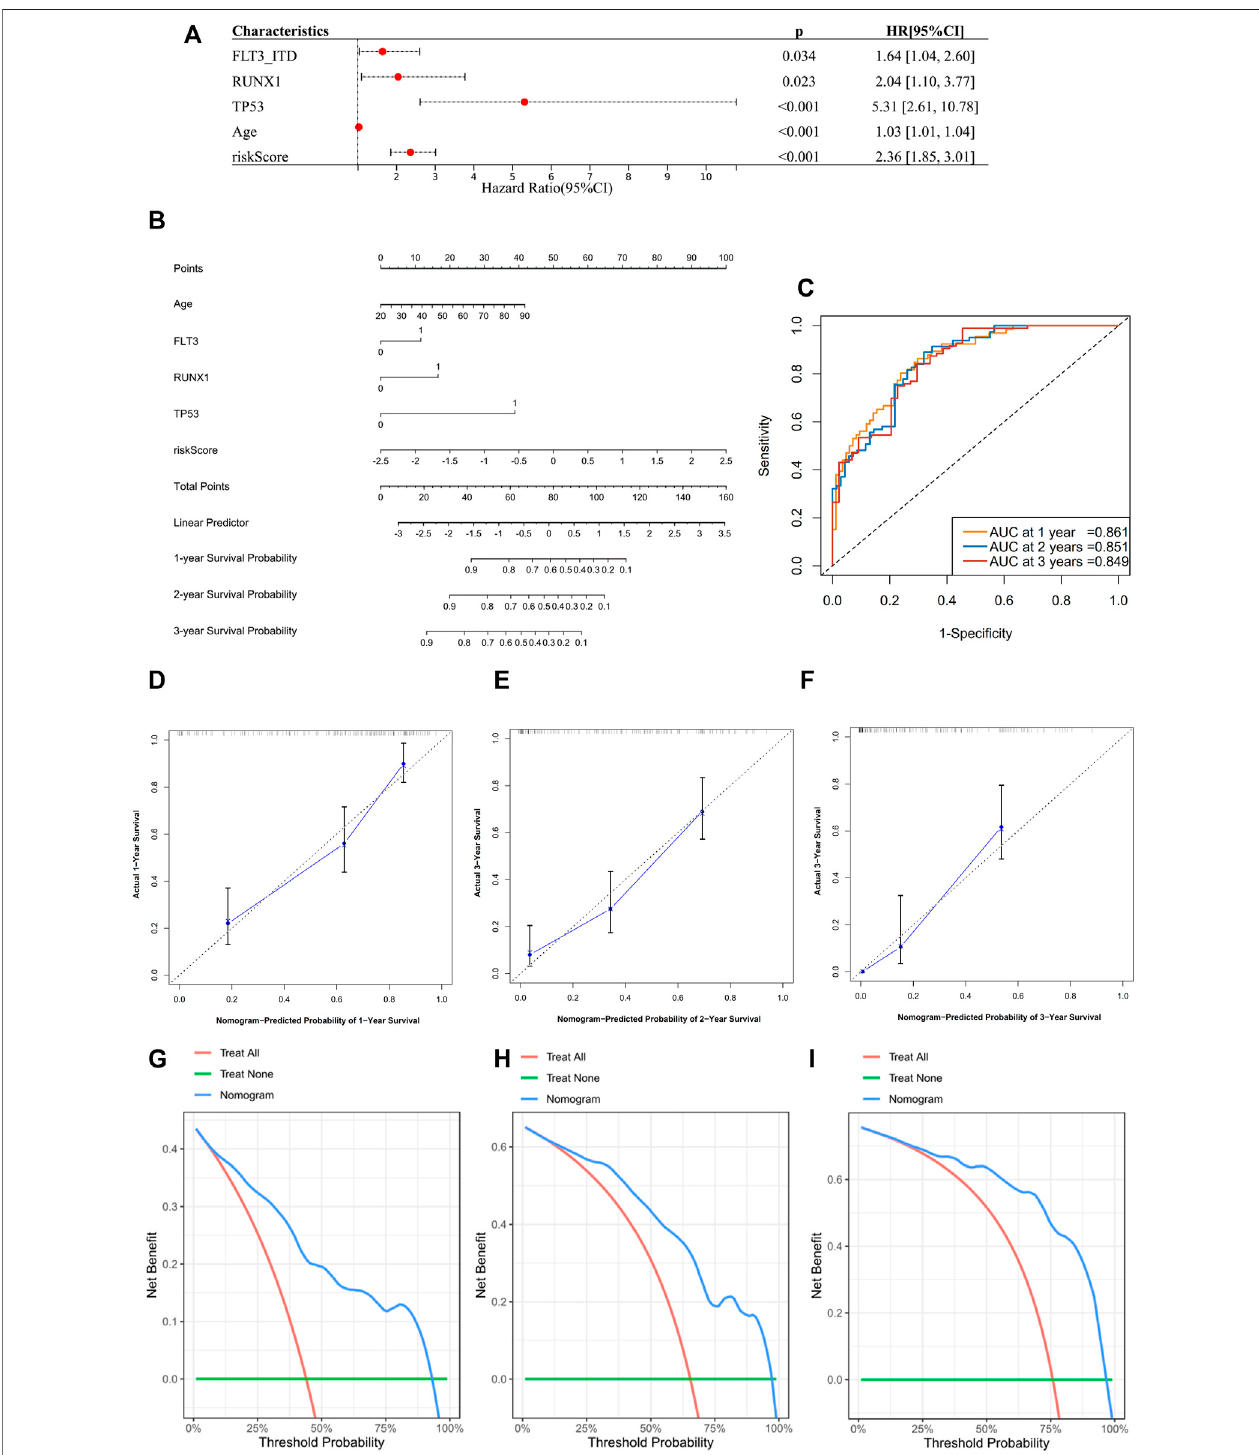
FIGURE 6 | Construction of a prognostic nomogram in TCGA datasets. (A) Multivariate analysis to validate independent prognostic factors from the previous multivariate Cox screening in Supplementary Figure S4N . (B) Nomogram for clinical diagnosis based on age, mutation status, and risk score. (C) ROCs for the nomogram. (D – F) Calibrationplotsforpredictingsurvivalat1,2,and3 years.Thex-axisrepresentsthepredictedsurvivalprobabilityfromthenomogram,andthey-axis represents the actual survival probability. (G – I) Decision curve analysis of the nomogram for 1-, 2-, and 3-year risk. The x-axis represents the threshold probability, andthey-axisrepresentsthenetbene fi t.Thegreenlinerepresentstheassumptionthatnopatientsdiedat1,2,or3 years.Theredlinerepresentstheassumptionthatall patients died at 1, 2, or 3 years, and the blue line represents the prediction model of the nomogram.